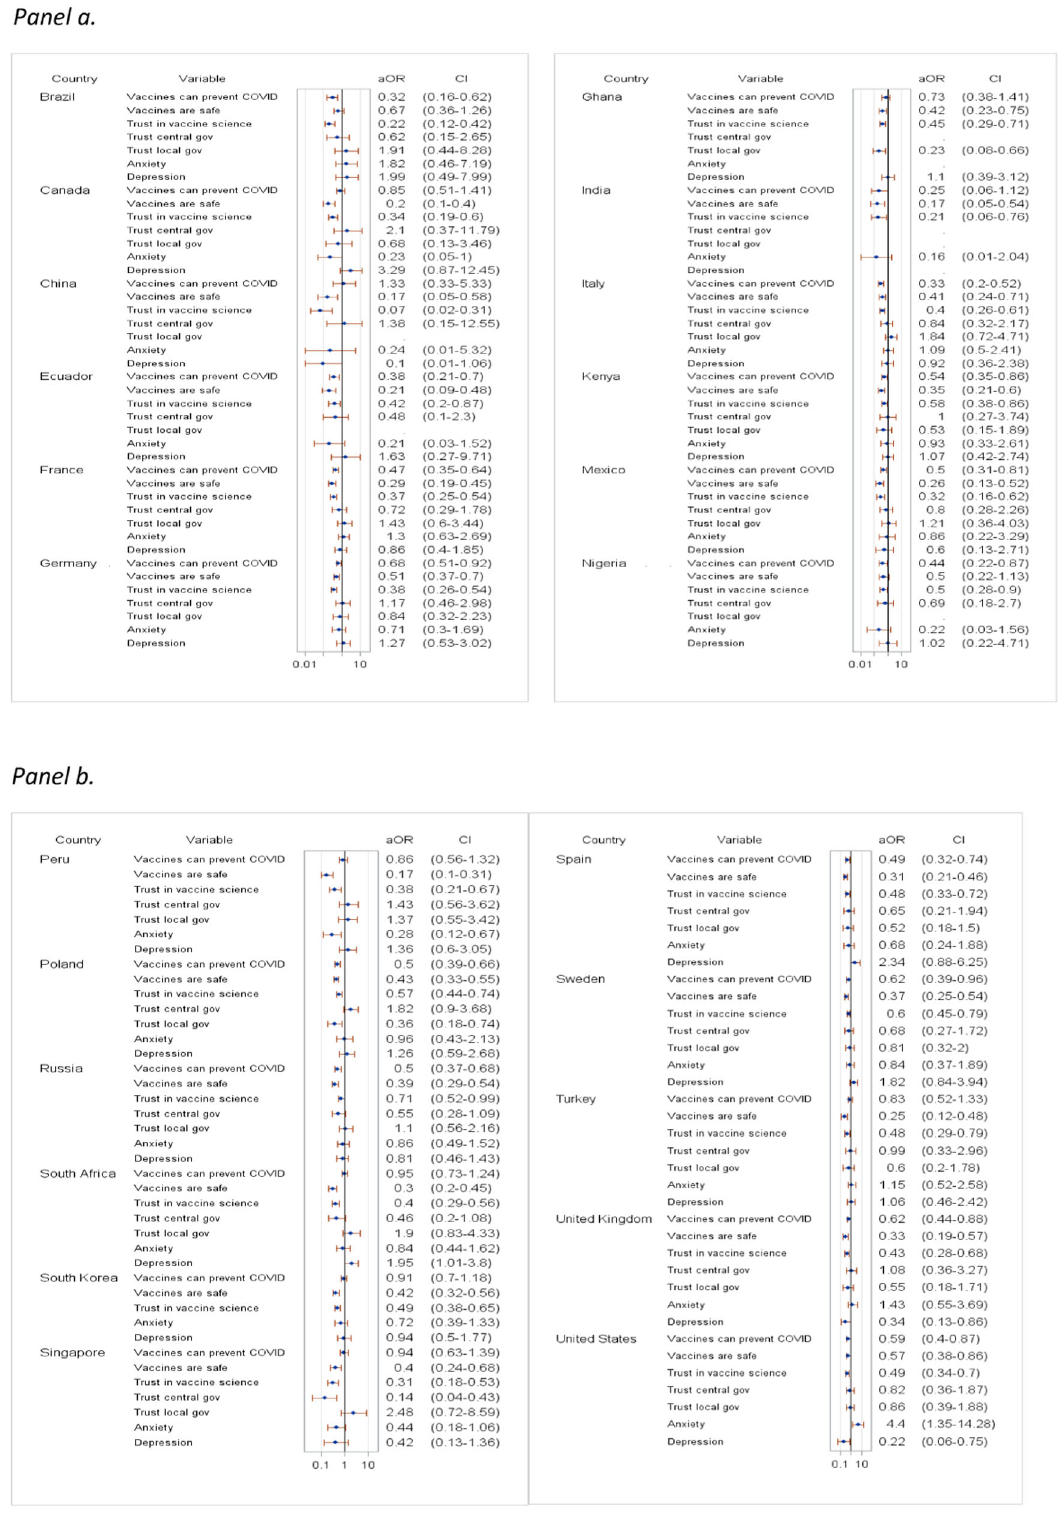
Fig. 5 Correlates of COVID-19 vaccine hesitancy with beliefs in a vaccine ’ s ability to prevent COVID-19, safety and trust in the vaccine science, trust in government, anxiety, and depression. a Correlates in Brazil, Canada, China, Ecuador, France, Germany, Ghana, India, Italy, Kenya, Mexico, and Nigeria. b Correlates in Peru, Poland, Russia, South Africa, South Korea, Singapore, Spain, Sweden, Turkey, the United Kingdom, and the United States. a , b Adjusted odds ratios (aOR) and 95% CI error bars (log scale) from weighted multivariable logistic regression, adjusted for socio-demographic factors and COVID-19